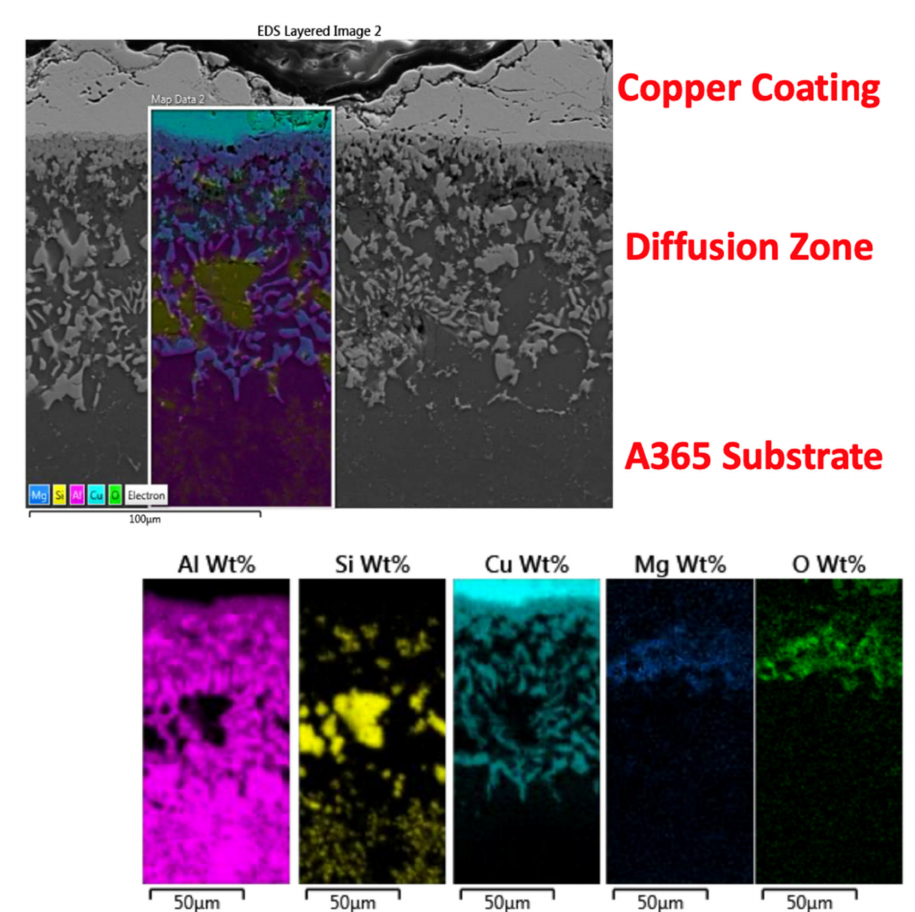
Figure 7. Presentation of the EDS mapping recorded for the Cu CGDS coated HPDC A365 substrate system in the thermally postprocessed